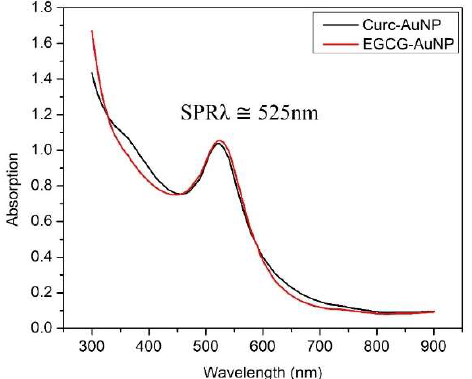
Figure 4. Ultraviolet Visible (UV-Vis) absorption at 525 nm signifies reduction of HAuCl 4 salt by the nutraceutical and formation of Gold nanoparticles (AuNPs). The peaks for Curc-AuNPs and epigallocatechin gallate (EGCG)-AuNPs are almost identical, and therefore we can expect both groups of NPs to have similar shape and size.